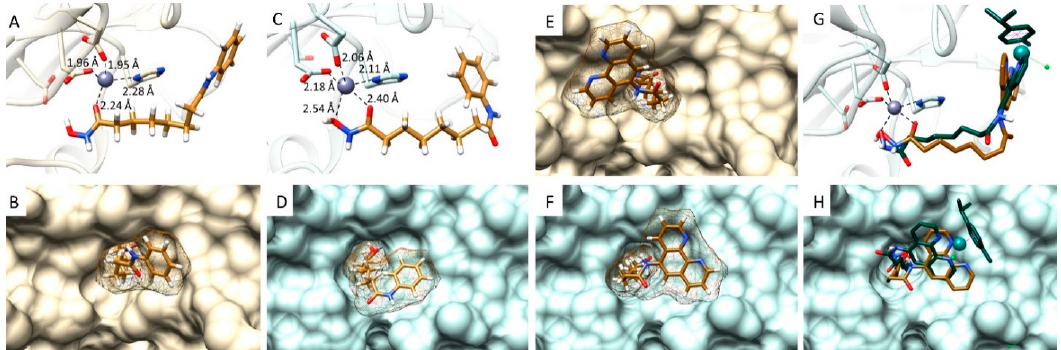
Figure 3. Computational docking studies showing A : Zn(II) coordination view of SAHA with ( B ) active site cavity entrance surface view of SAHA with HDAC1; ( C ) Zn(II) coordination view of HDAC1; B : active site cavity entrance surface view of SAHA with HDAC1; C : Zn(II) coordination view of SAHA with HDAC6; D : active site cavity entrance surface view of SAHA with HDAC6; E : SAHA with HDAC6; ( D ) active site cavity entrance surface view of SAHA with HDAC6; ( E ) active site active site cavity entrance surface view of L 1 with HDAC1; F : active site cavity entrance surface view cavity entrance surface view of L 1 with HDAC1; ( F ) active site cavity entrance surface view of L 1 with of L 1 with HDAC6; G : Zn(II) coordination view of L 1 (gold) and 1 (teal) overlapped with HDAC6; H : HDAC6; ( G ) Zn(II) coordination view of L 1 (gold) and 1 (teal) overlapped with HDAC6; ( H ) active site cavity entrance surface view of L 1 and 1 overlapped with